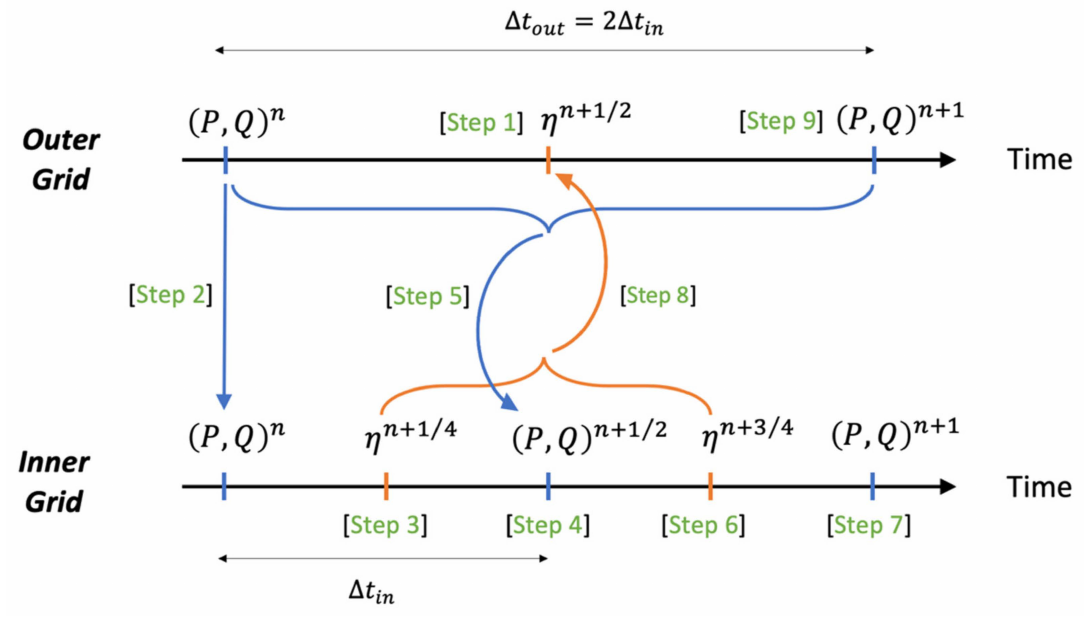
Figure 2. Grid-nesting procedure between the outer and inner grid in ∆ t out / ∆ t in = 2. We note that ∆ t ∆ t out and in indicate the time step of the outer and inner grids, respectively. η is the free surface elevation, ( P , Q ) are the volume-flux components, and the superscript n denotes the time label. This figure is replotted from